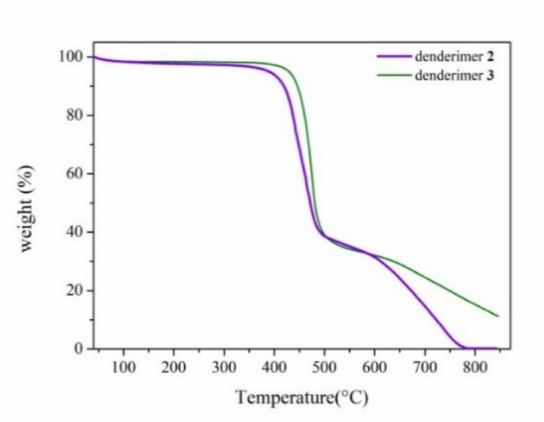
Figure 2. The mass spectrum of dendrimer 3 .